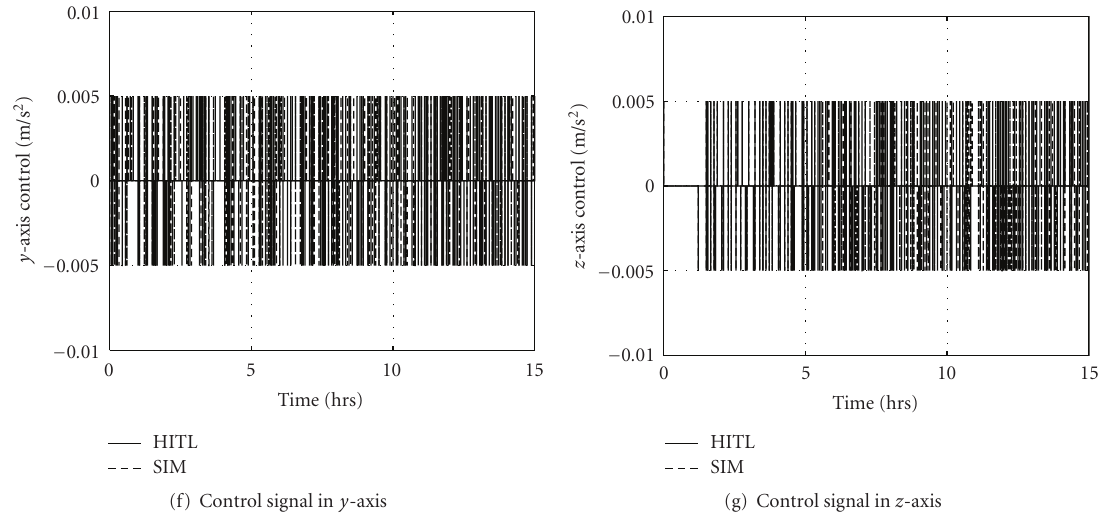
Figure 11: HITL simulation results with Fuzzy Logic control (control interval: 200 seconds; maximum firing time: 2